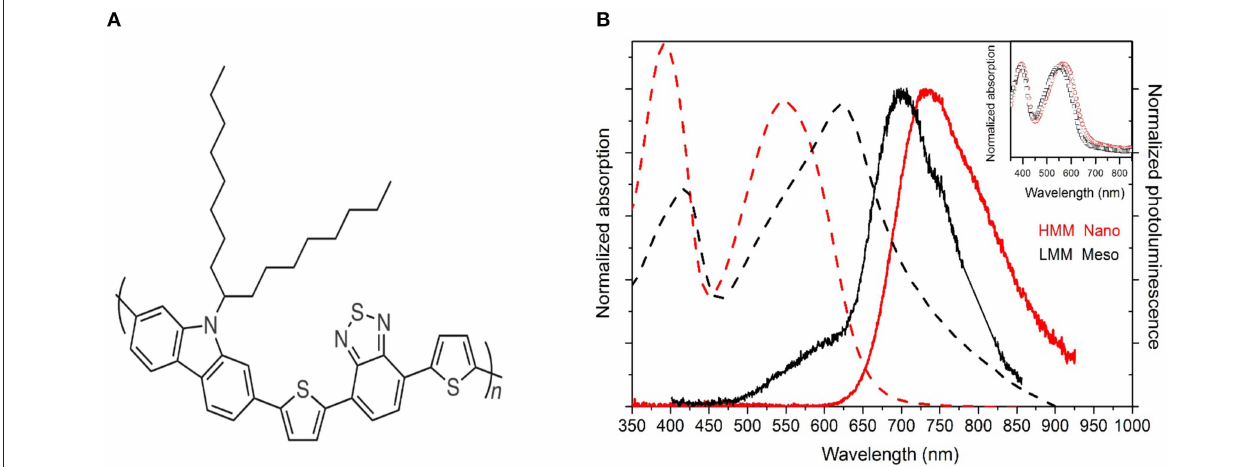
FIGURE 1 | (A) Chemical structure of PCDTBT. (B) Normalized absorption (broken line) and photoluminescence spectra (solid line) for the HMM nanoparticle (red) and LMM mesoparticle (black) suspensions. The absorption spectra of spin coated films from the HMM (red open circles) and LMM (black open squares) pristine polymers are also shown in the inset. The pristine polymers are in film form after spin-coating from chloroform solution.